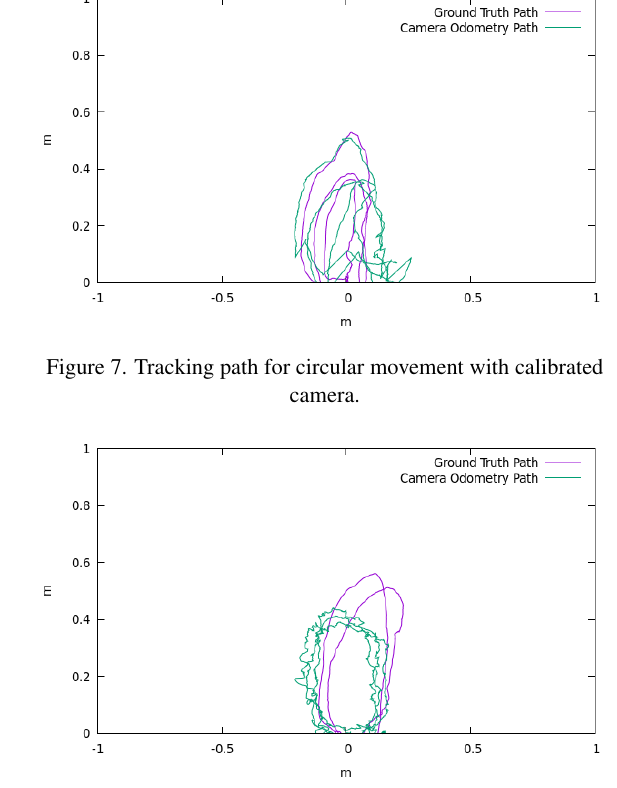
Figure 8. Tracking path for circular movement with non-calibrated camera.